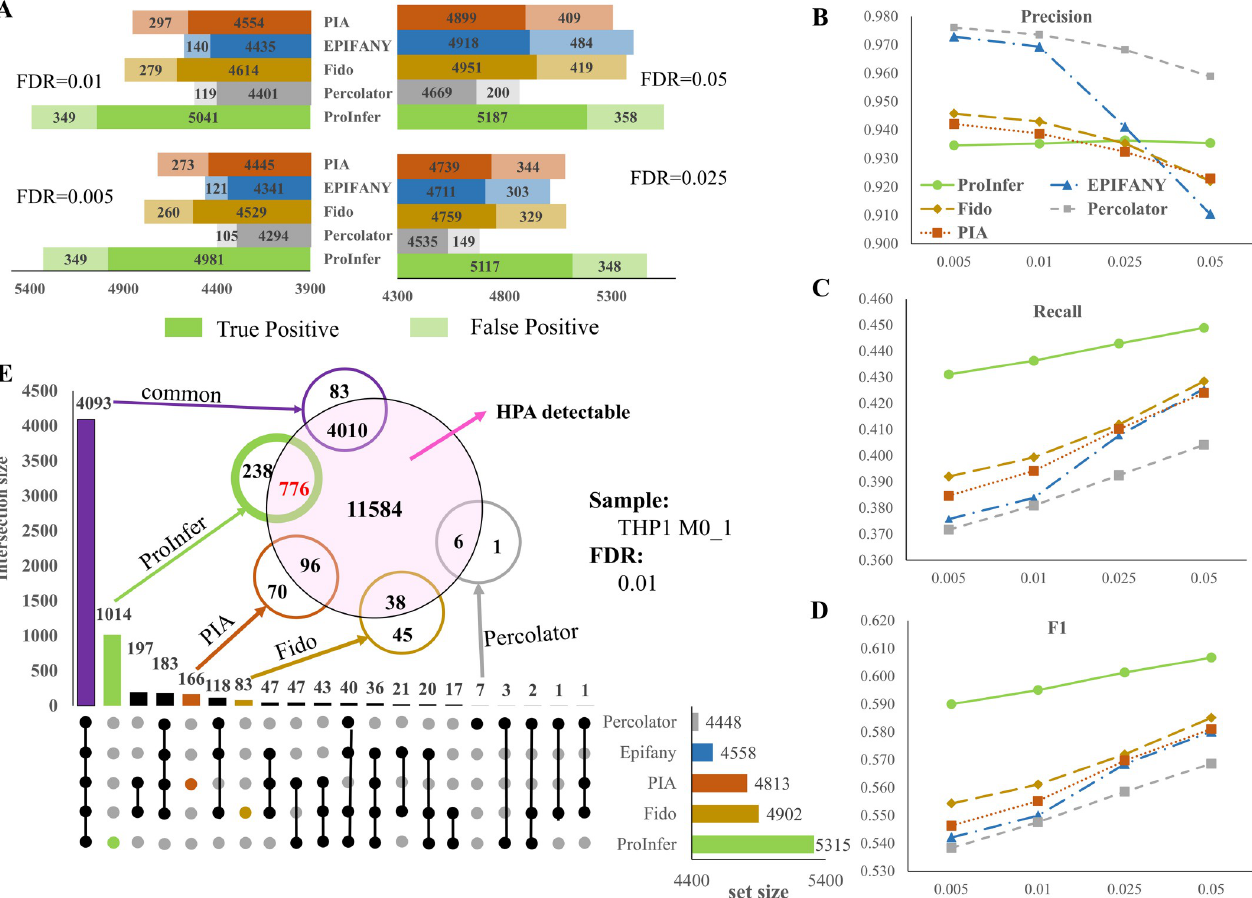
Fig 2. Performance evaluation of various tools tested on 3 replicates of human THP1 dataset. A shows average numbers of true positives (in deep colors) and false positives (in light colors) reported in 3 replicates of THP1 sample with FDR of 0.005, 0.01, 0.025 and 0.05 respectively with hyperparameters optimized with Hela data. B, C & D show the changes of precision, recall and F1 values of competing tools under different protein reporting FDRs. E is a Venn diagram revealing the overlap of proteins reported by different tools and validation status of proteins that reported only by a specific tool.